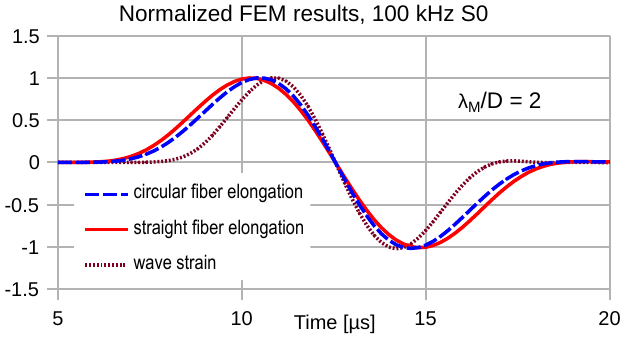
Figure 8. Plane wave S 0 (100 kHz) strain and converted signals for both transducer elongation configurations for λ M = 2 D .